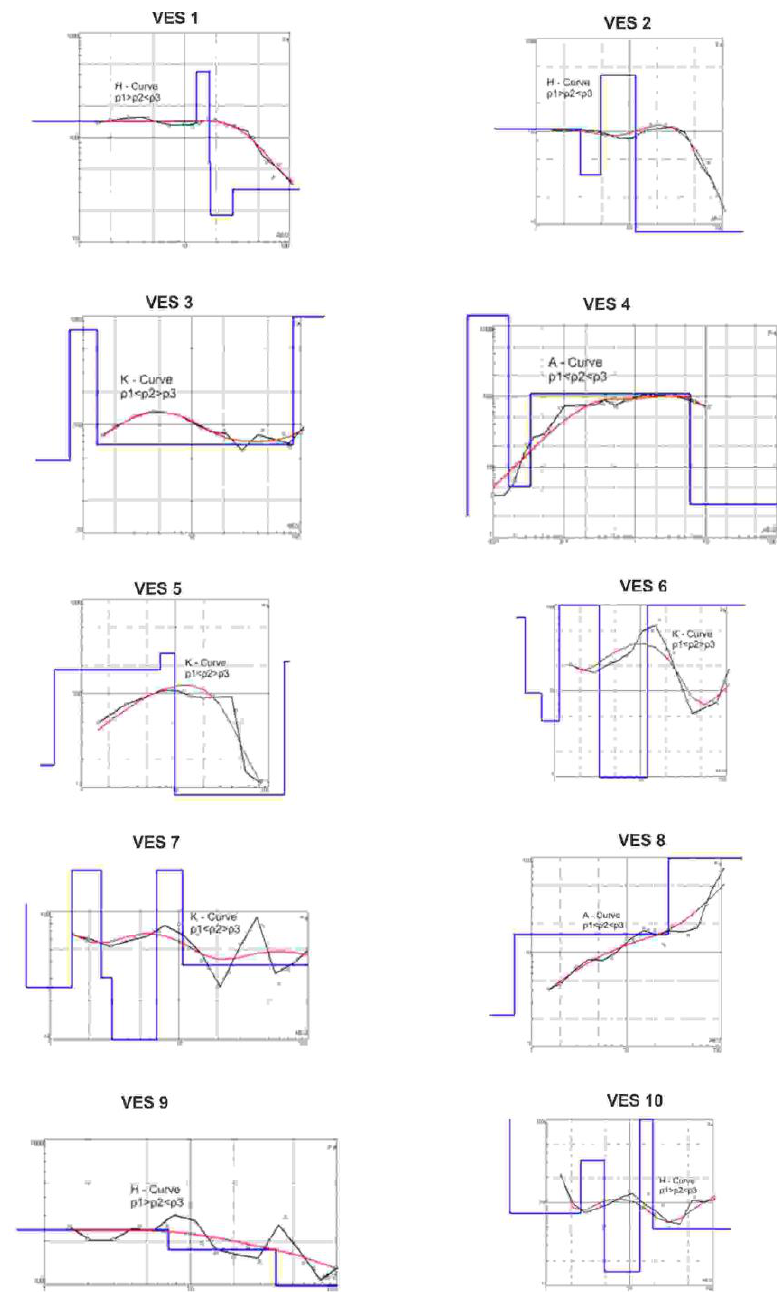
Fig. 3. Field curve types obtained from the ten VES geoelectric sections on the